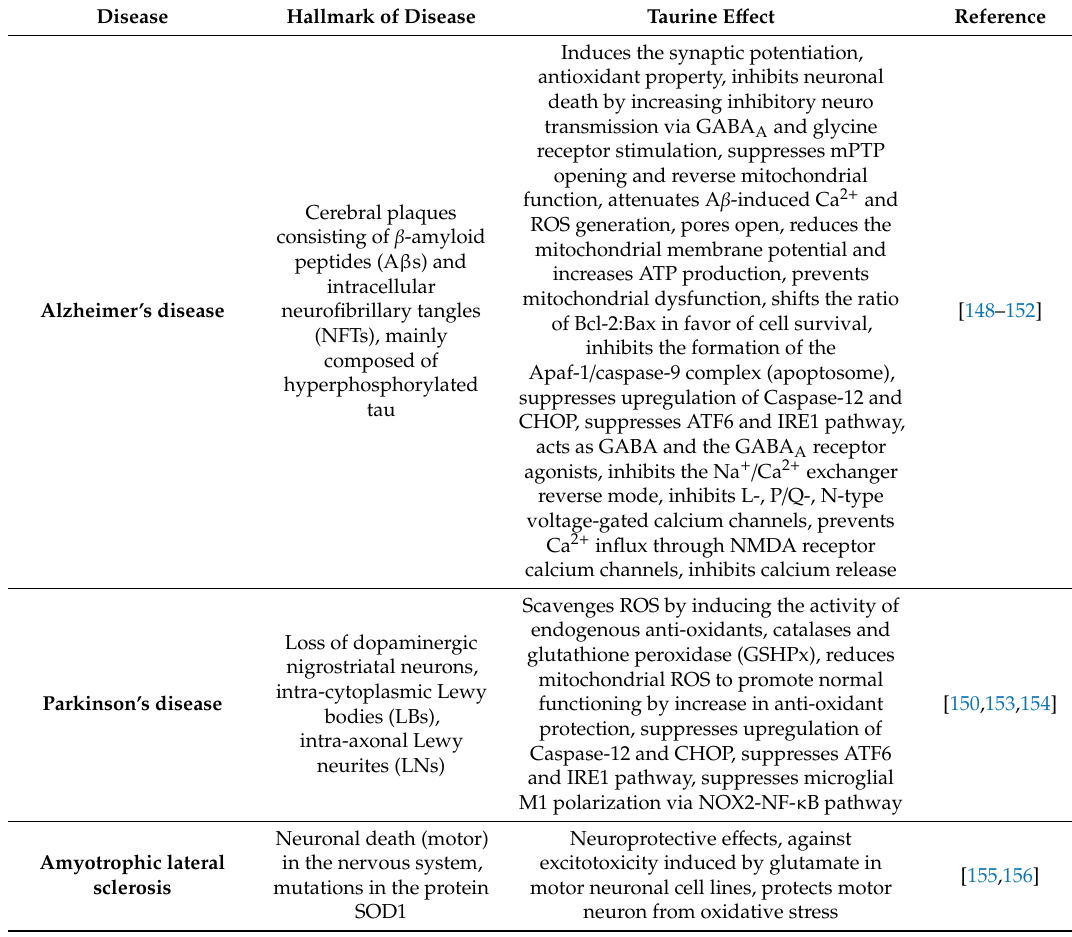
Table 1. Role of Taurine in